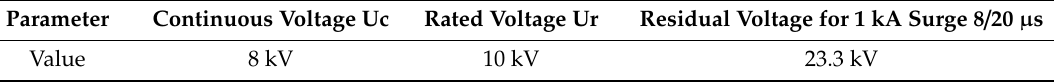
Table 4. Parameters of the POLIM-D8N surge arrester used in the test setup